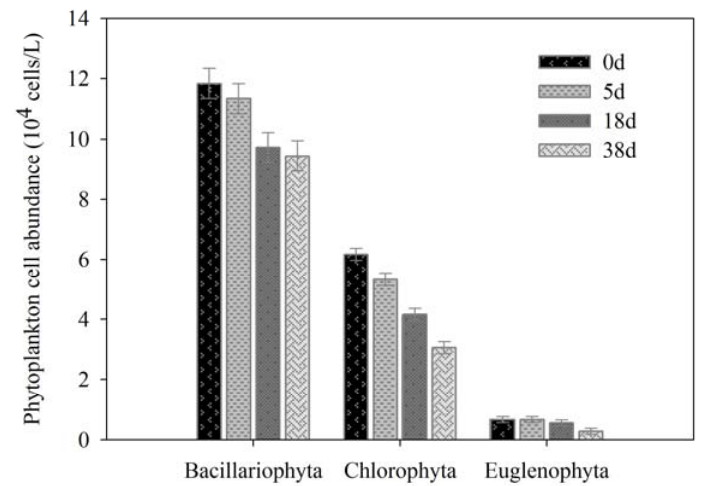
Figure 1. Variations of phytoplankton cell abundance (phylum).